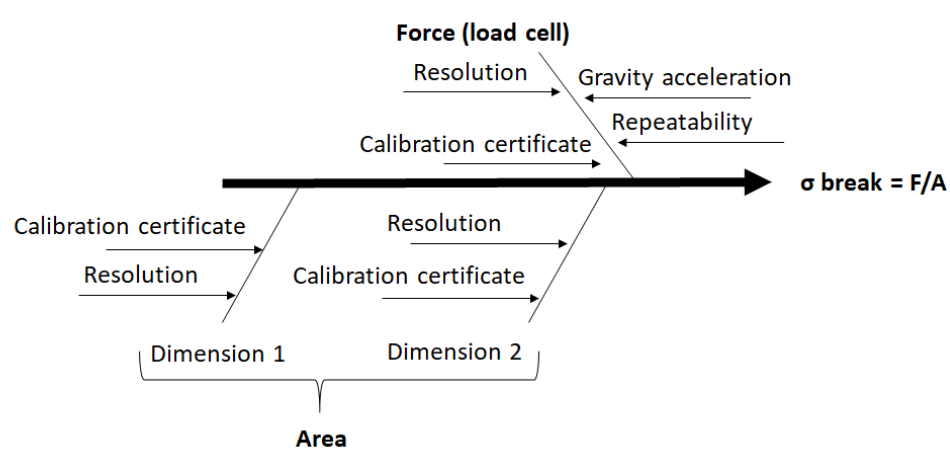
Figure 4. Cause and effect diagram for calculating measurement uncertainty in the compression strength test. strength